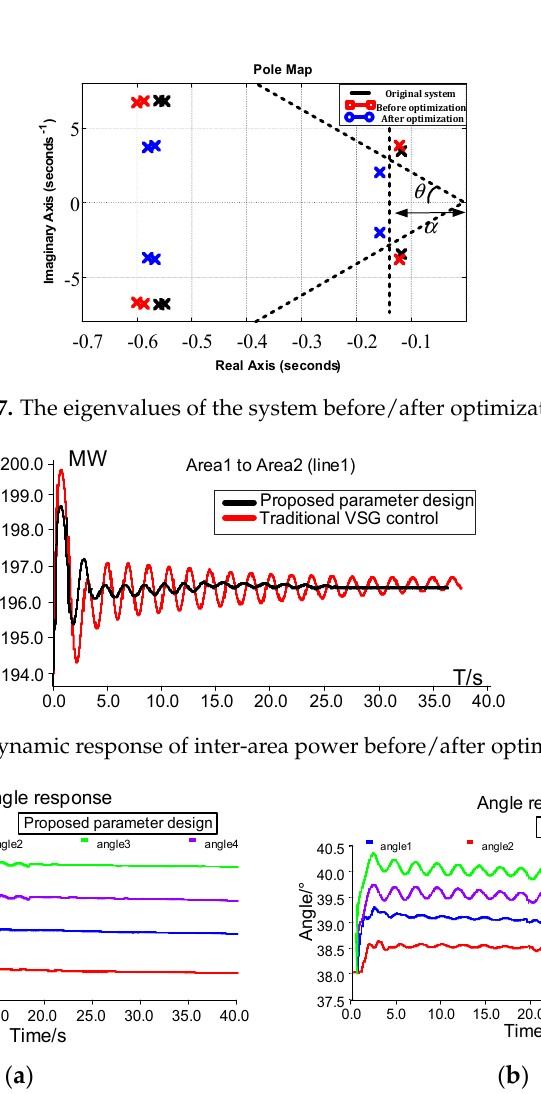
Figure 9. Dynamic response of power angle before/after optimization. ( a ) After optimization, ( b ) before optimization.